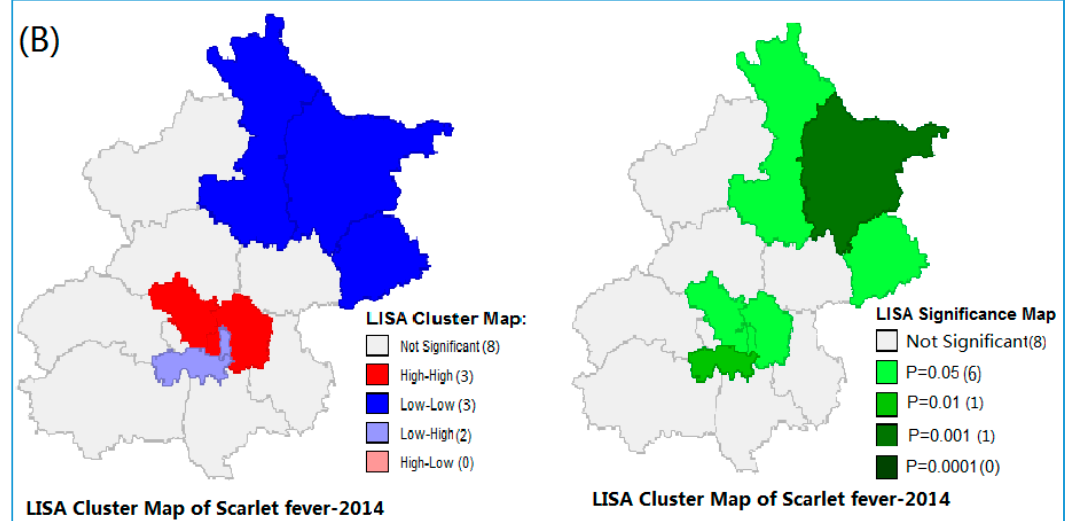
Figure 3. Local Moran’s I analysis (LISA) of Scarlet fever clusters in Beijing, from ( A ) 2013 and ( B ) 2014.